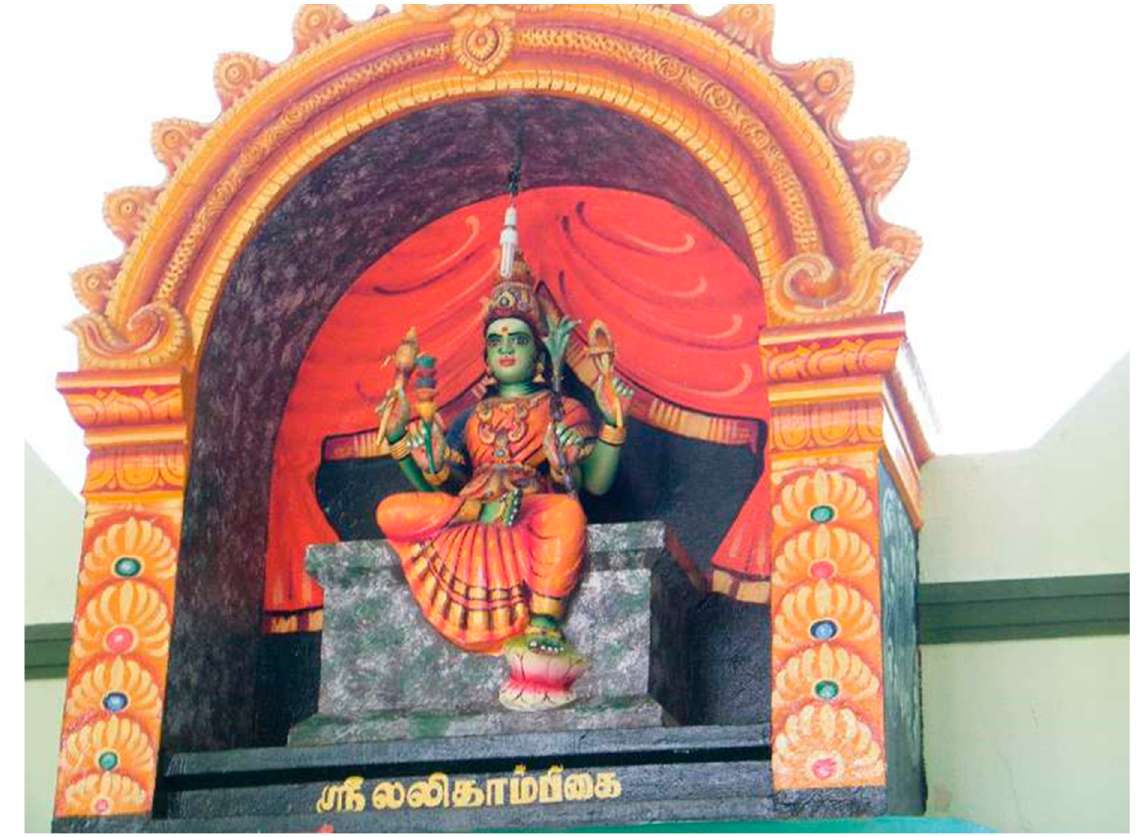
Figure 3. An image of the goddess Lalit ā mbik ā , Lalit ā mbik ā temple,